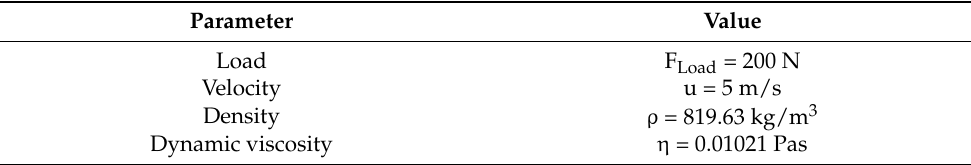
Table 1. Parameters of the simulations in the hydrodynamic lubrication regime. Parameter Value Load F Load = 200 N Velocity u = 5 m/s Density ρ = 819.63 kg/m 3 Dynamic viscosity η = 0.01021